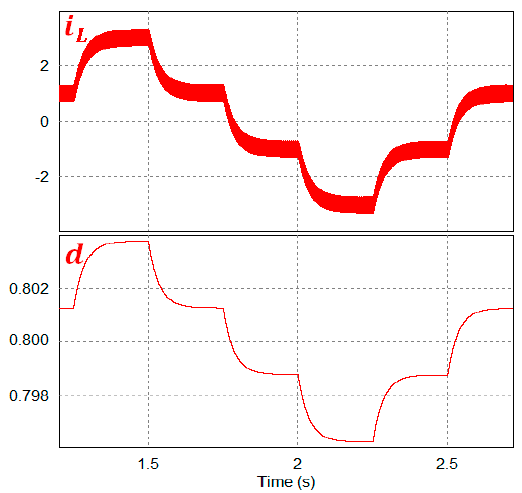
Figure 13. Simulated waveforms during validation test of the power transfer mode.